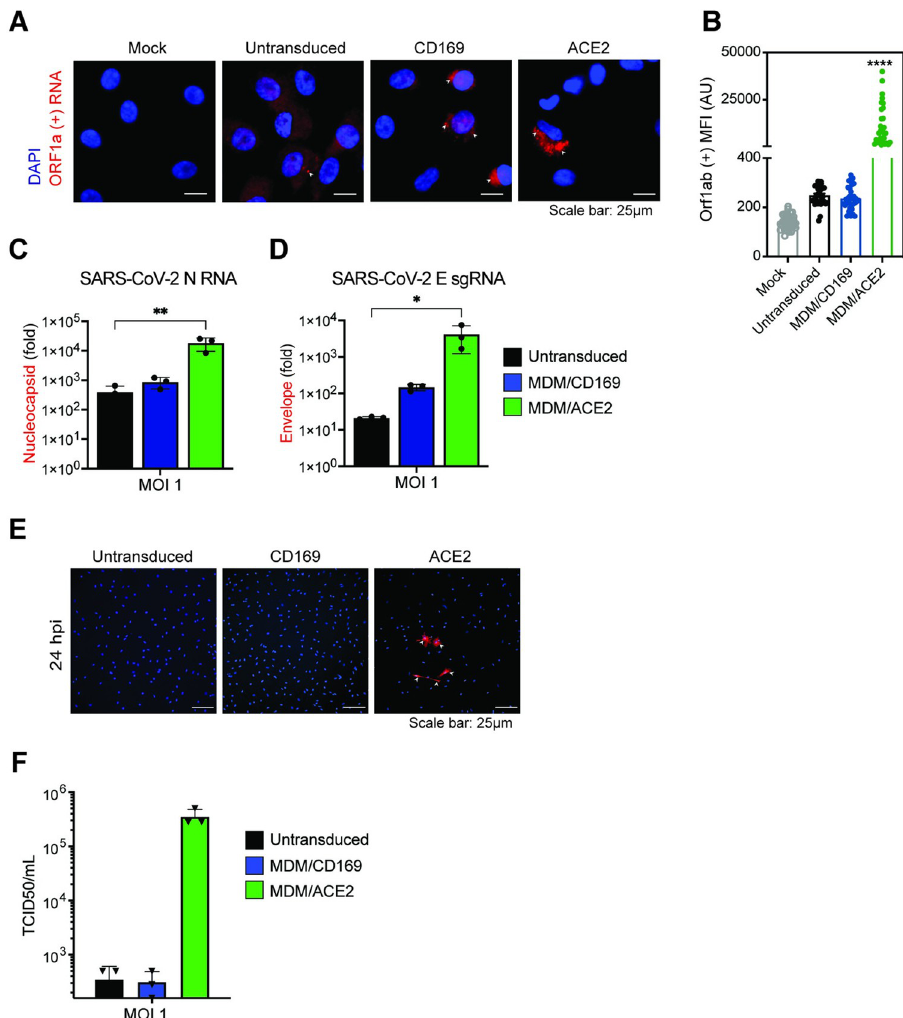
Fig 5. CD169-mediated virus entry leads to restricted SARS-CoV-2 infection in primary MDMs. ( A ) Expression of SARS-CoV-2 genomic RNA in primary MDMs imaged using smFISH probes against Orf1a (NSP 1–3), and DAPI for nuclear staining. Data are a representative of 2 independent experiments. Bar = 25 μ m. ( B ) Quantitation of mean fluorescence intensities (MFI) based on the presence of SARS-CoV-2 gRNAs determined from 10–20 independent fields. Significant differences between the groups were determined by one-way ANOVA showing mean fluorescence intensity ± SEM for each group. ( C - D ) Total RNA from SARS-CoV-2 infected primary untransduced MDMs (MOI = 1, 24 hpi), or MDMs overexpressing either CD169 or ACE2 was analyzed by RT-qPCR for expression of total N RNA ( C ), and envelope sgRNA ( D ). Fold expression normalized to mock (uninfected) control for each donor. Significant differences between groups were determined by one-way ANOVA followed by the Dunnett’s post-test ( C - D ), comparing to untransduced control for each donor. P -values: � < 0.1; �� < 0.01; ���� < 0.0001. ( E ) Representative immunofluorescence images (20x) from primary untransduced MDMs, or MDMs overexpressing either CD169 or ACE2, infected with SARS-CoV-2 (MOI = 1, 24 hpi) and stained for nucleus (DAPI, blue), and SARS-CoV-2 N (red). Bar = 25 μ m. ( F ) Culture supernatants from SARS-CoV-2 infected primary MDMs from multiple donors were harvested at 24 hpi and viral titers determined by TCID 50 assay.